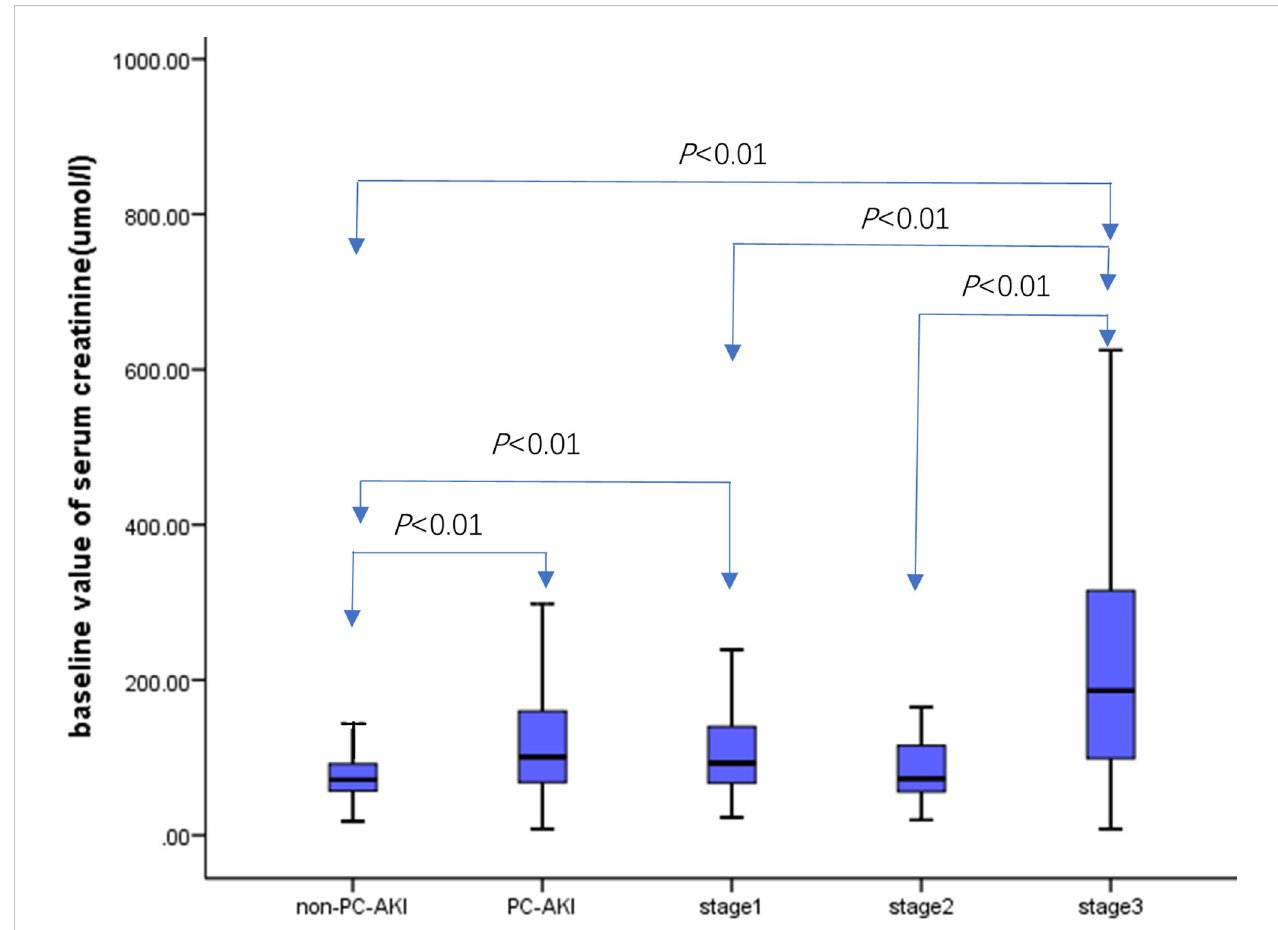
FIGURE 4 Comparison of baseline value of serum creatinine in different PC-AKI stages.